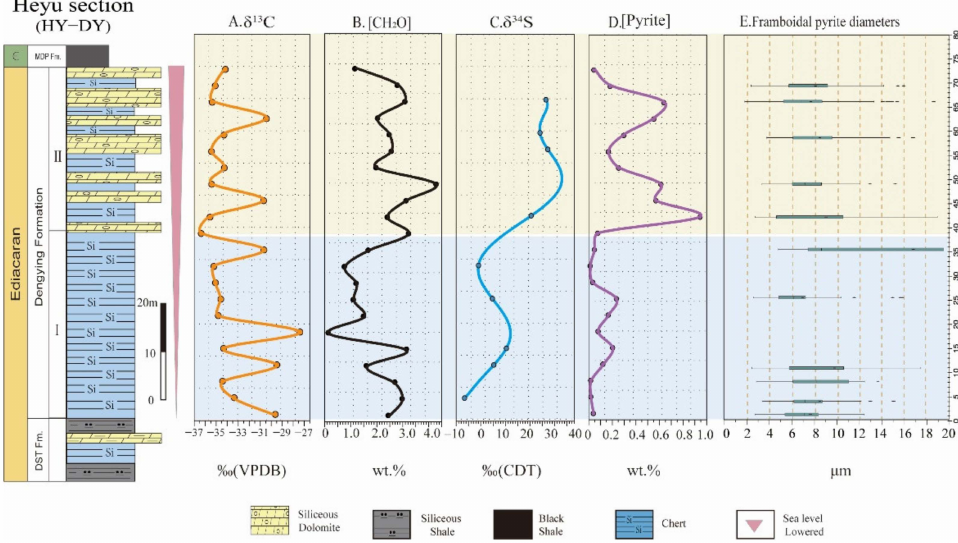
Figure 3. Stratigraphic column, geochemical profiles, and diameter of framboidal pyrite in the Heyu